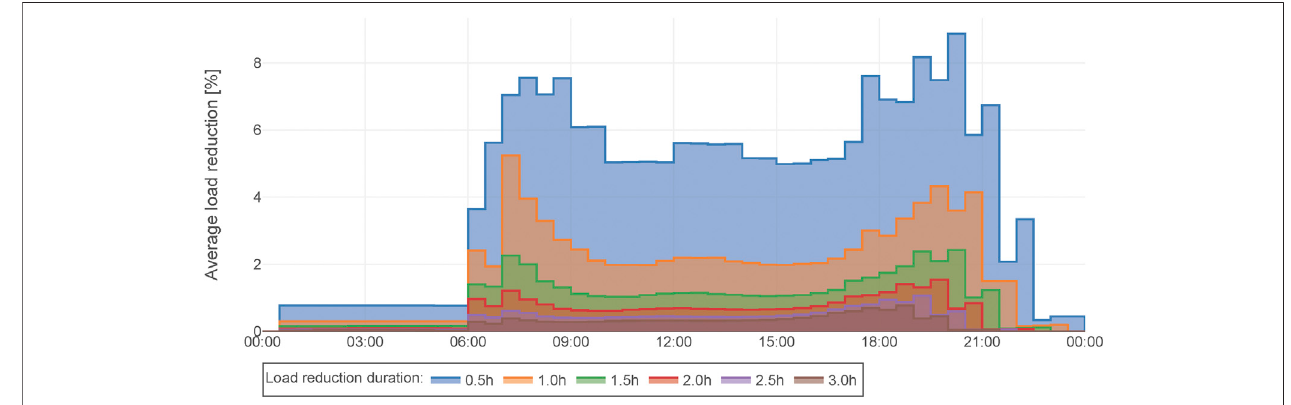
FIGURE 8 | Average load reduction potential time